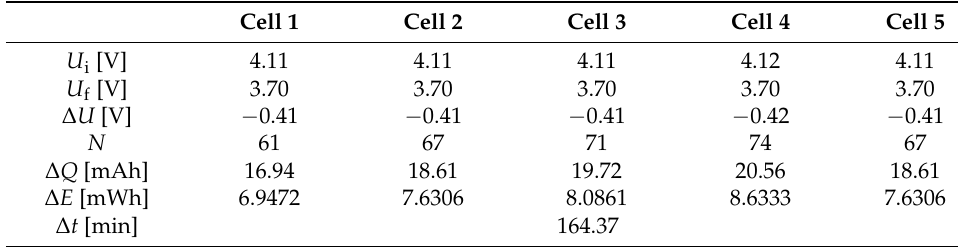
Table 6. Discharge system configuration data.